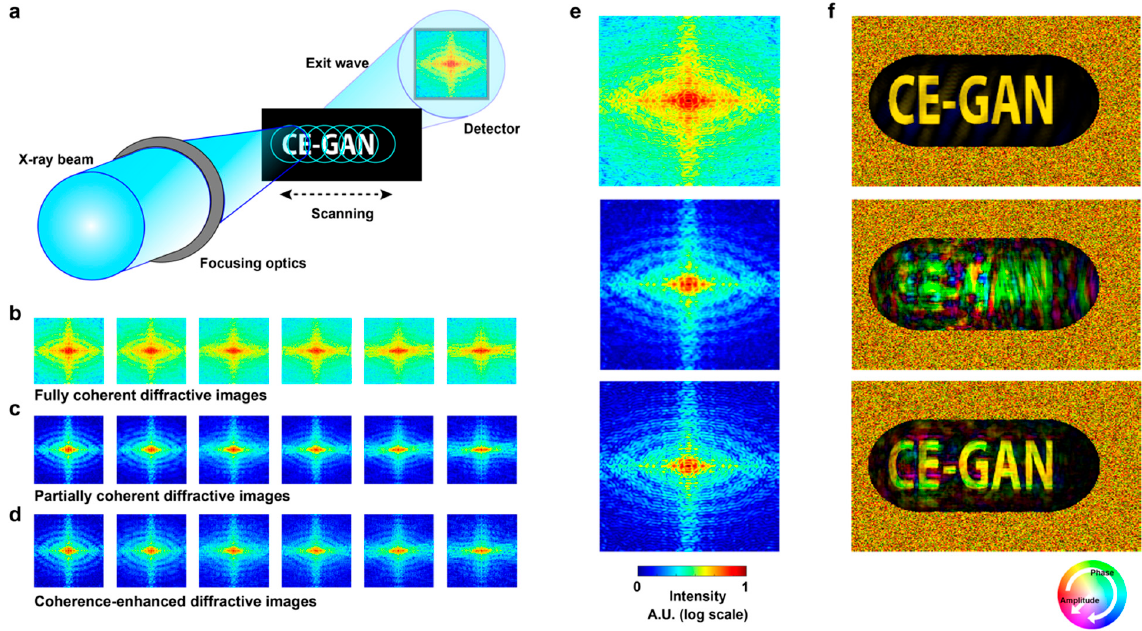
Figure 5. The performance of coherence-enhanced GAN in ptychography. ( a ) Schematic setup for ptychography. A 2D object is scanned with a focused fully or partially coherent beam while collecting far-field diffraction images on a detector. The overlapping ratio between the adjacent illuminating areas is 73% ( b – d ) Six diffraction images from fully coherent, partially coherent, and coherence-enhanced illuminations, respectively. ( e ) The enlarged images of the left side images in ( b , c ), and ( d ) (from top to bottom). ( f ) The reconstructed images of three different series of diffraction images, fully coherent diffractive images, partially coherent diffractive images, and coherence-enhanced diffractive images (from top to bottom).